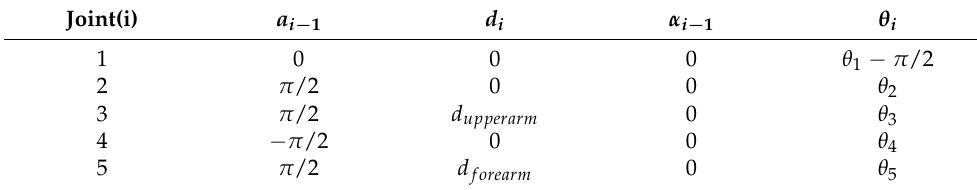
Table 1. Modified Denavit–Hartenberg